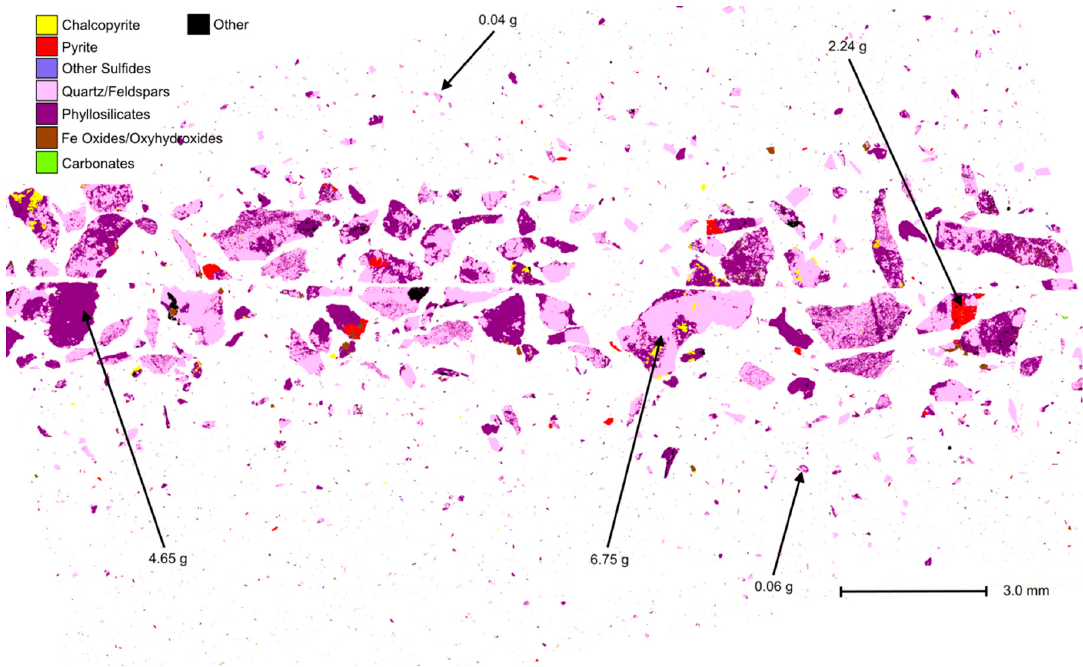
Figure 4. Mineral map produced for a Field Scan analysis of an entire transverse section surface. Particle segregation is clearly evident. Arrows indicate the mineralogically calculated particle masses for the entire particle that they point to. Note the concentration of heavier, sulfide-rich particles towards the center of the transverse section, which represents the bottom of the original section. Table 4. Correlation table for pyrite with Fe and S chemical assays. A very strong and statistically significant correlation is identified between pyrite and S.